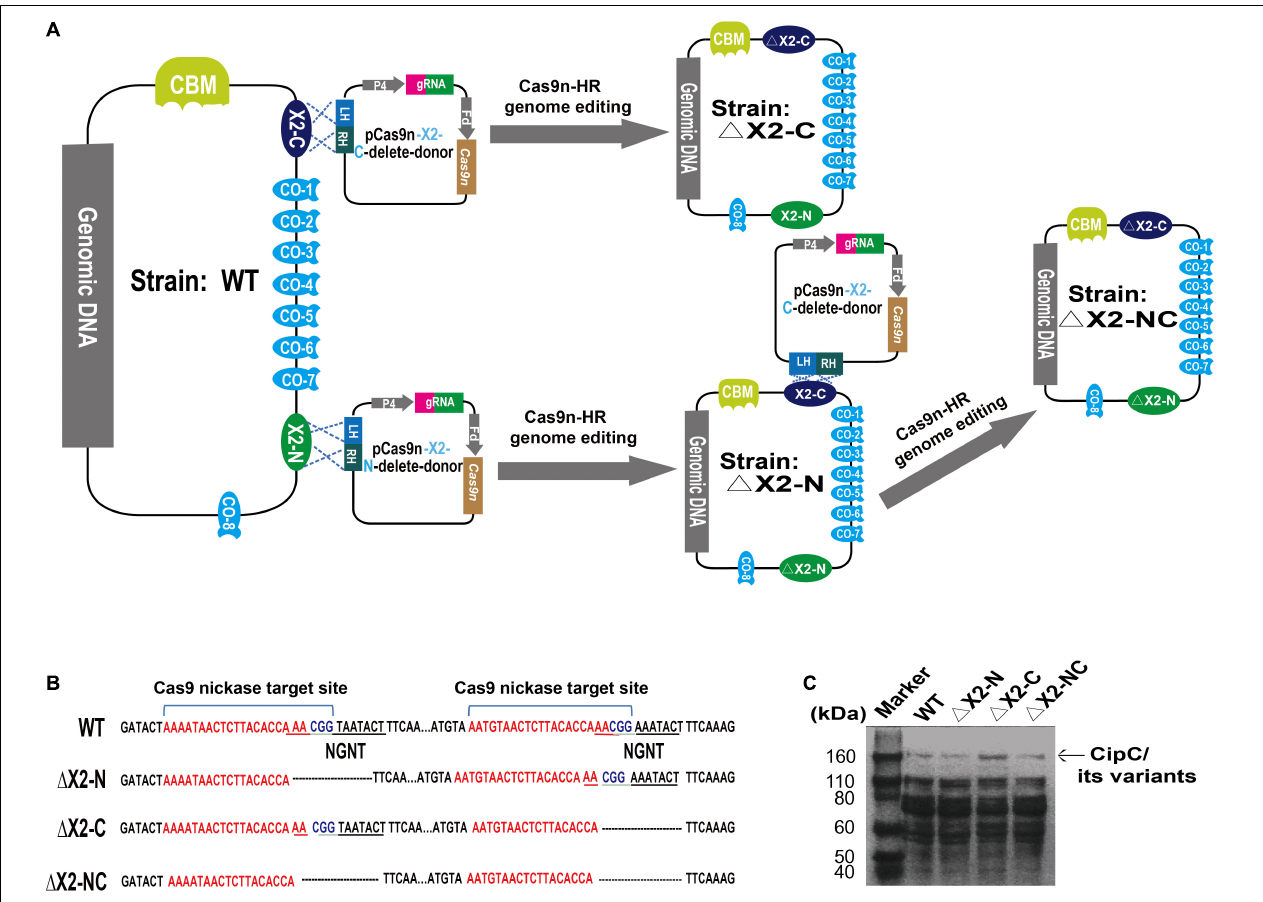
FIGURE 1 | Precise deletion of the conserved motif from the X2 modules to maintain the structural integrity of the CipC protein. (A) An overview of the strategy for constructing the dual X2 module mutant by the Cas9 nickase-based genome editing. Both plasmids pCas9n-X2-C-delete-donor and pCas9n-X2-N-delete-donor were used for the (cid:49) X2-NC mutant construction. LH, left homologous; RH, right homologous; P4, P4 promoter (Xu et al., 2015); Fd, ferredoxin promoter (Xu et al., 2015); CBM, carbohydrate binding module; CO, Cohesin. (B) DNA sequence showing the deletion of conserved motif from X2 modules in the cipC gene. (C) SDS-PAGE analysis of cellulosomes extracted from WT and all mutant strains (15 µ g protein/lane).